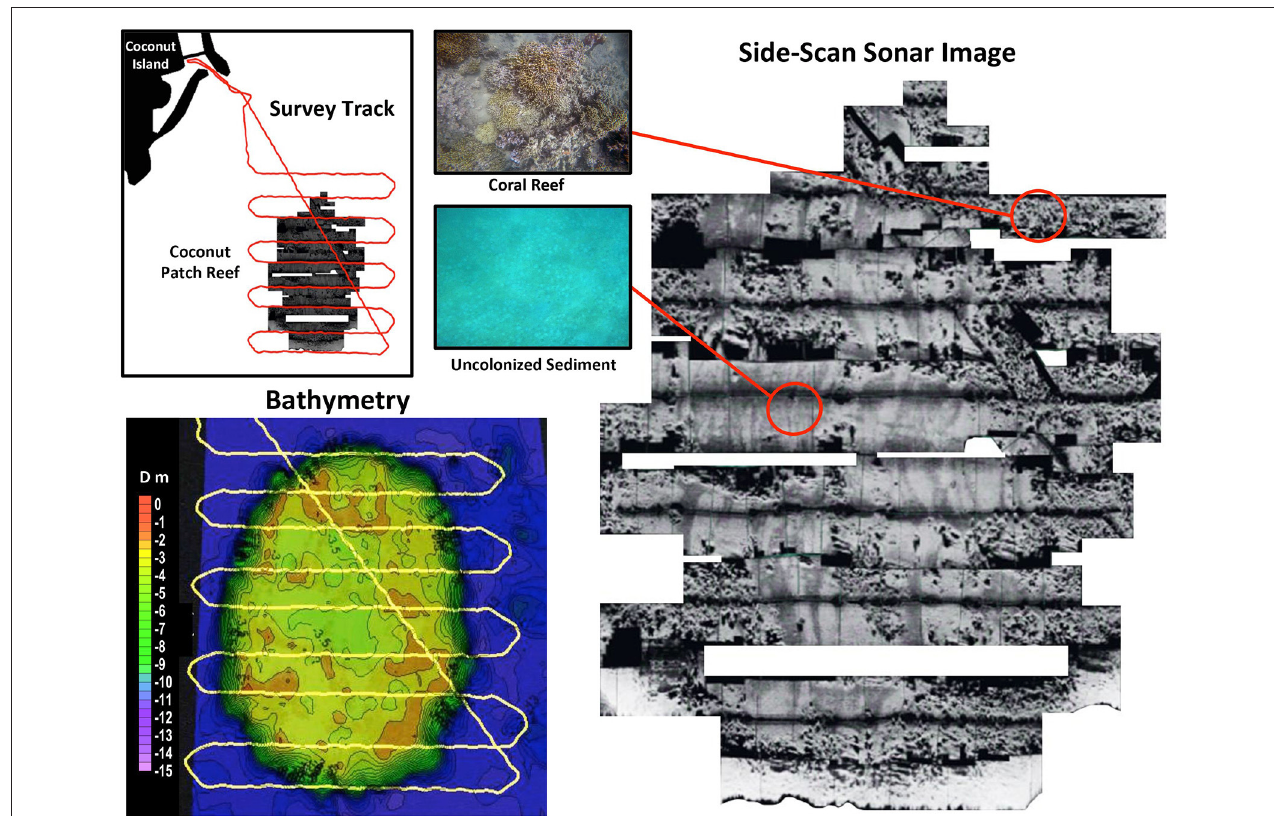
FIGURE 5 | Acoustical data from an autonomous survey was used to map bathymetry within and around the coconut patch reef and identify areas colonized by coral (dark, heterogeneous tones in acoustical backscatter) and uncolonized sediment (lighter, more homogeneous tones). Visual inspection of imagery from a down-looking, in-water camera (GP1) was used to validate the interpretation of the acoustical backscatter signals.